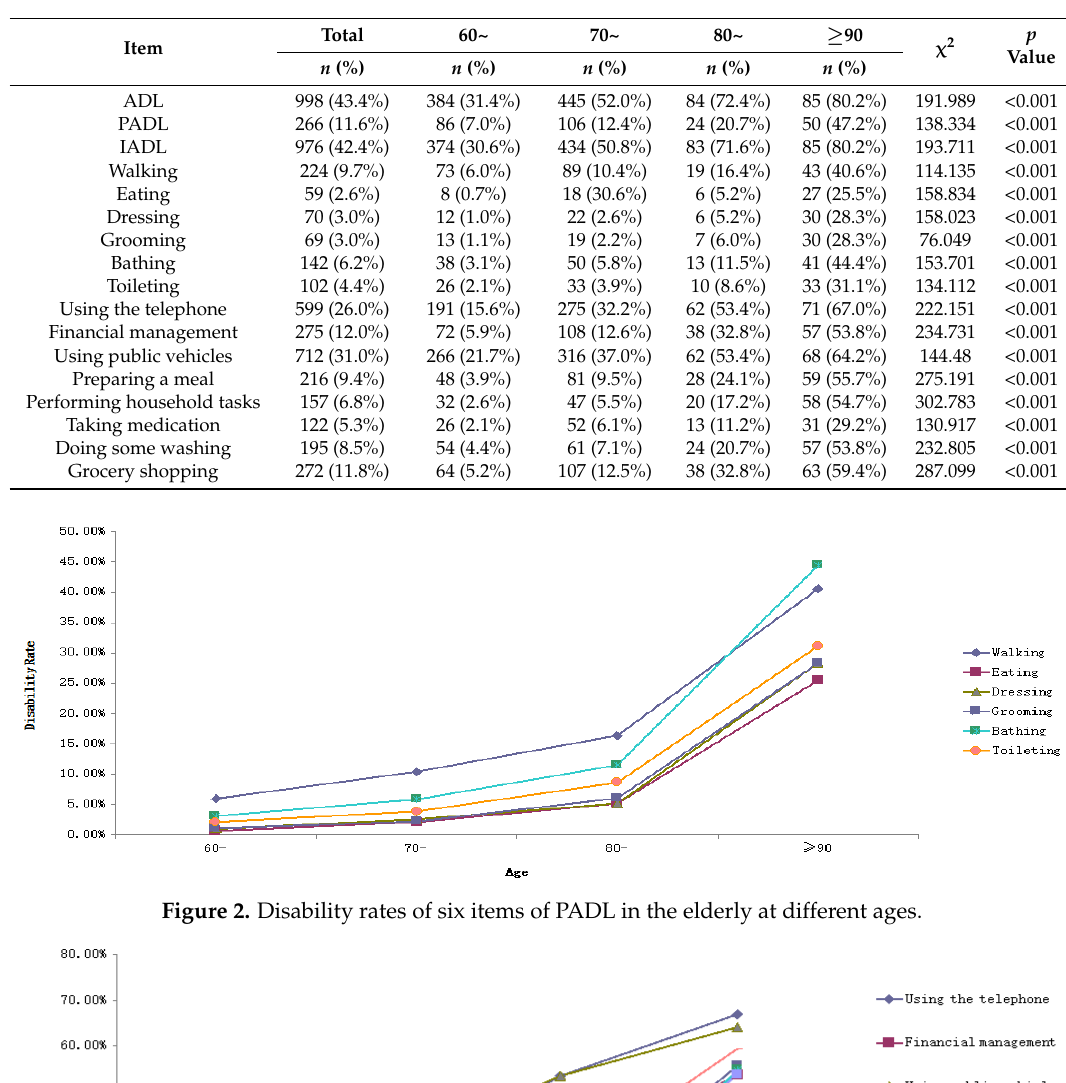
Table 2. Trends of disability rates among different age groups in ADL, PADL, IADL, and their items.